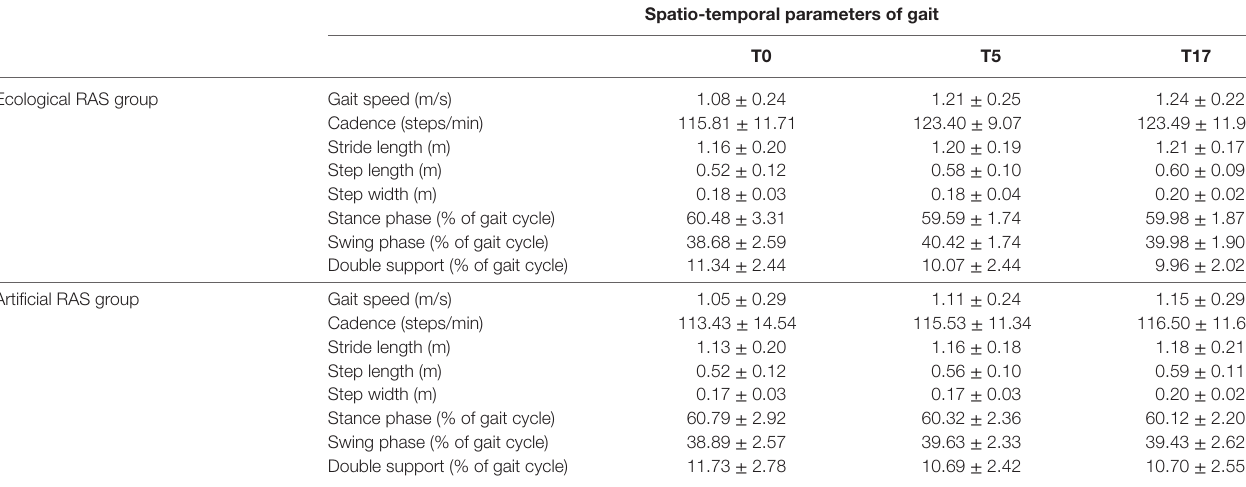
TaBlE 2 | Comparison between spatio-temporal parameters assessed before and after rehabilitation for each group.